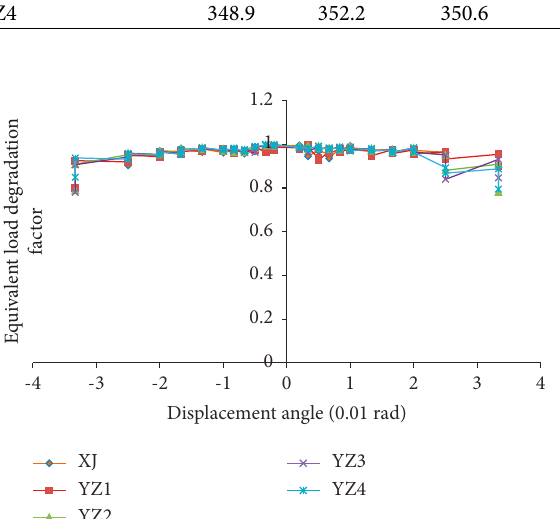
Figure 9: Strength degradation